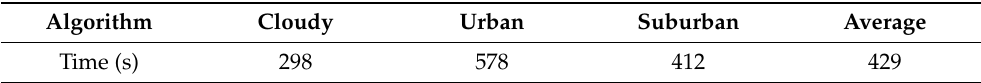
Table 1. The time consumption of image enhancement